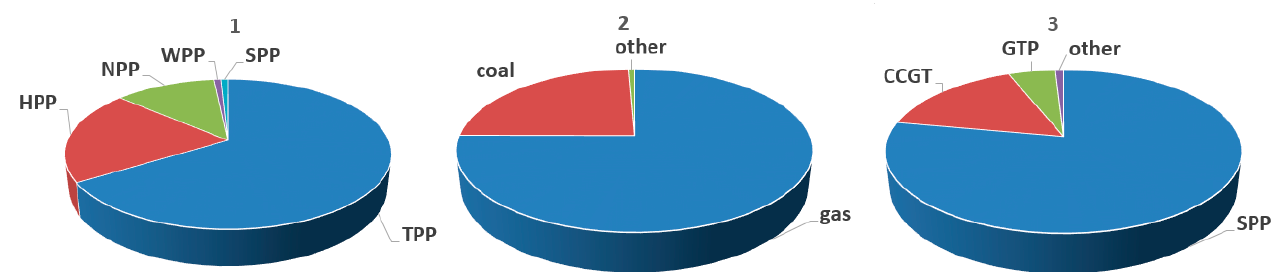
Figure 2. Power plants of the Russian Federation (1—structure of power plants by type of generating equipment; 2—structure of TPPs by fuel types; 3—structure of TPPs by type of generating equip- ment): HPP—hydroelectric power station; NPP—nuclear power plant; WPP—wind power